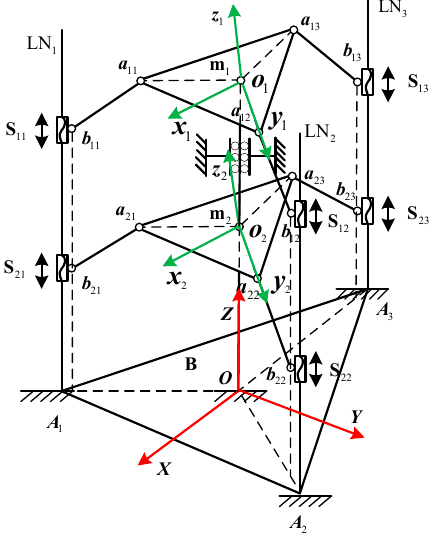
Figure 2. 2(3PUS+S) parallel manipulator topological structure.